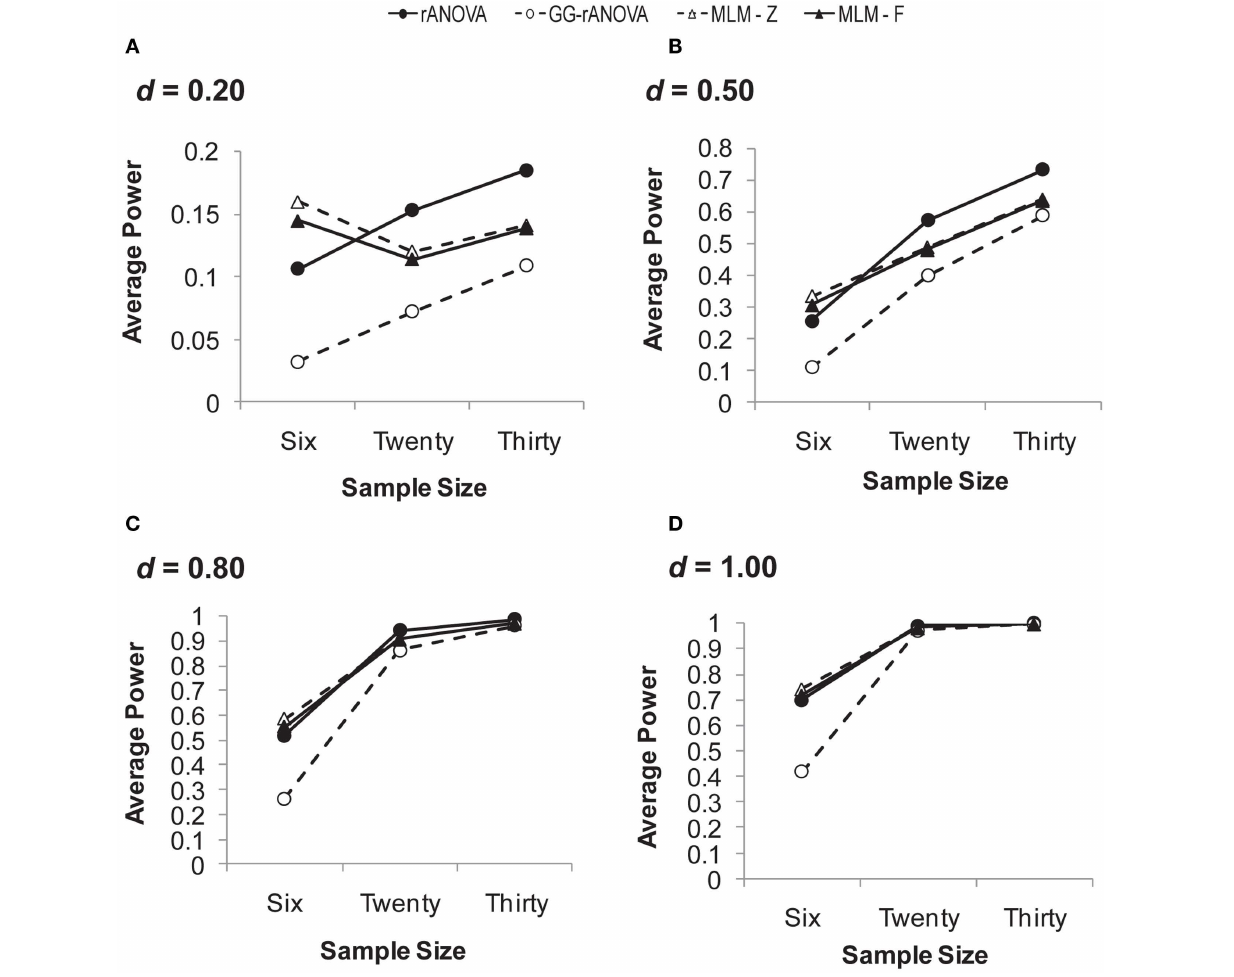
FIGURE 5 |Average power on the session by group interaction with six measurement waves . (A) for d = 0.20; (B) for d = 0.50; (C) for d = 0.80; (D) for d = 1.00. d = standardized difference between group slopes,